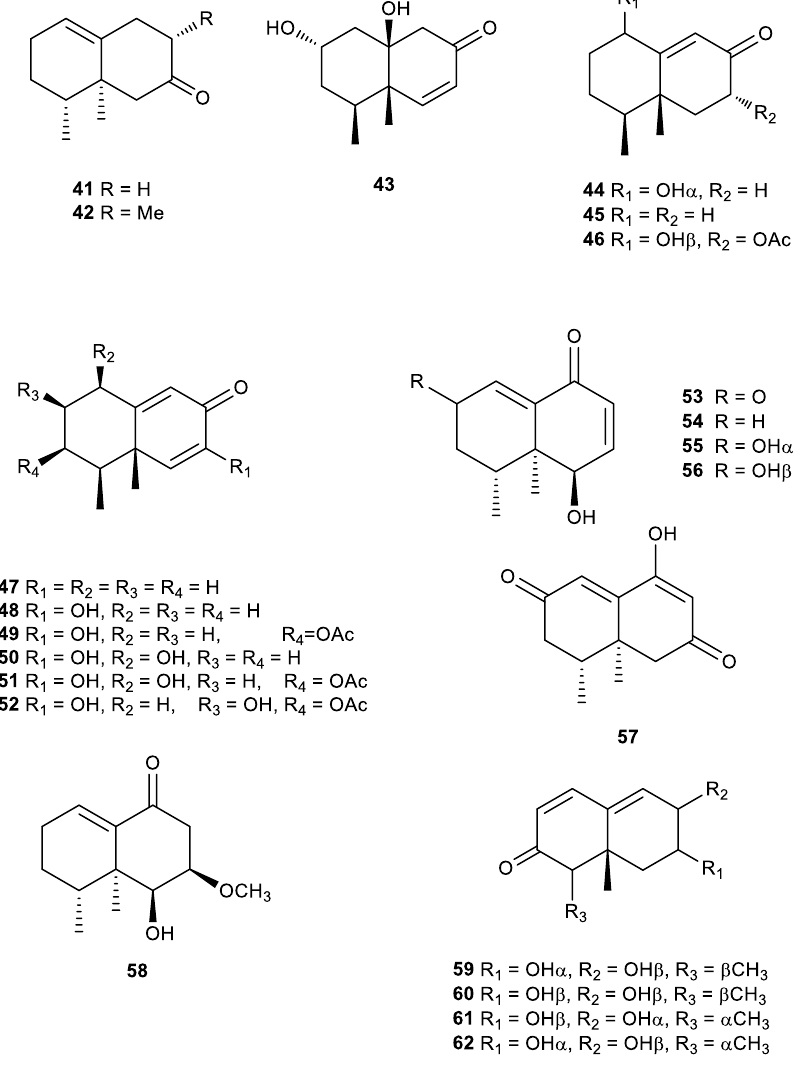
Figure 6. Some isolated 11,12,13-tri- nor -eremophilanes.